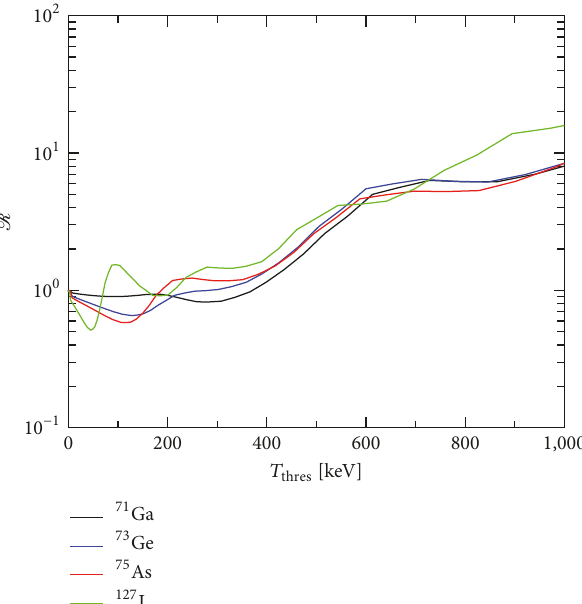
Figure 12: The ratio R as a function of the detector threshold.